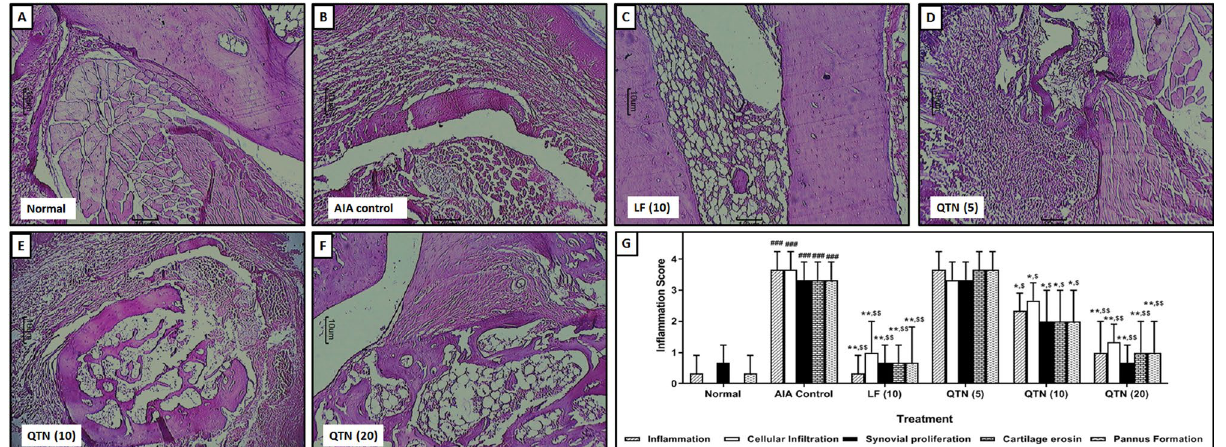
Figure 4. Effects of QTN on the histopathology of tibiotarsal joints. Representative histological images from ( A ) normal, ( B ) AIA control, ( C ) leflunomide (10 mg/kg), ( D ) QTN (5 mg/kg), ( E ) QTN (10 mg/kg) and ( D ) QTN (20 mg/kg) treated rats. Images stained with H&E (× 100). The quantitative representation of histological score ( G ). Data were expressed as mean ± S.E.M. (n = 3), and one-way ANOVA followed by the